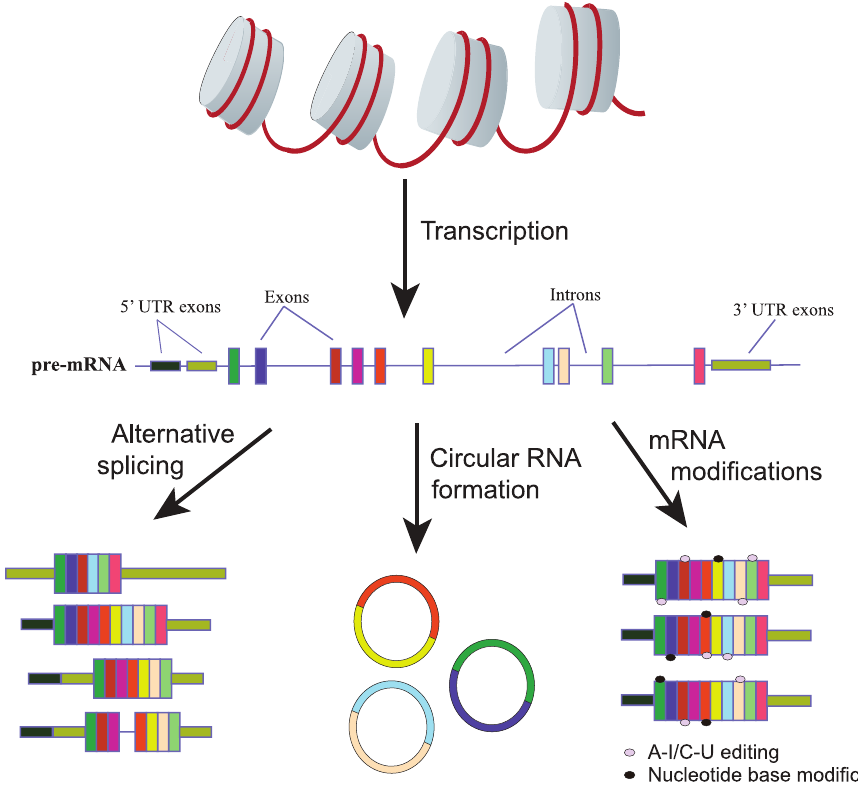
Figure 1. Alternative splicing, circular RNA formation, and mRNA modifications are the major mechanisms generating much of the mRNA diversity. Alternative splicing results in the selective inclusion or skipping of particular exons as well as alternate 5 ′ and 3 ′ untranslated region (UTR) selection within a processed mRNA transcript. In some cases, alternative splicing also results in intron retention events. Circular RNA formation occurs because of back splicing of the 3 ′ end of a downstream exon to the 5 ′ end of an upstream exon. Lastly, mRNAs can be modified through editing mechanisms converting A and C nucleotides to I and U nucleotides, respectively, as well as through the addition of functional groups on either the base or the sugar moiety of a